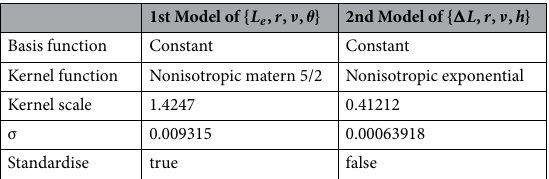
Table 1. Optimised hyperparameters of trained Gaussian process regression models.